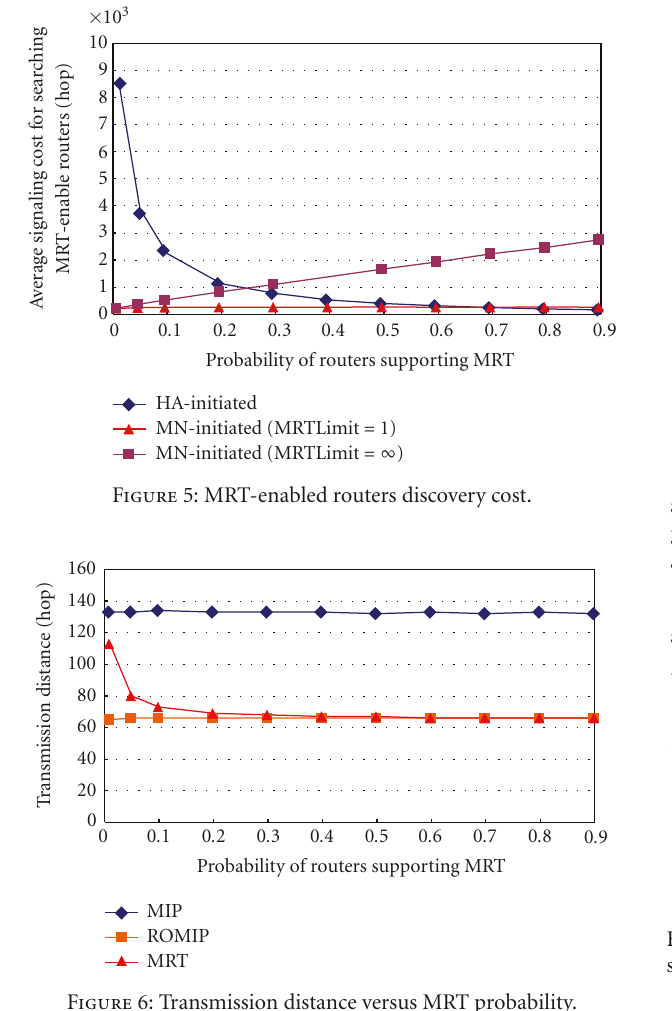
Figure 6: Transmission distance versus MRT probability.